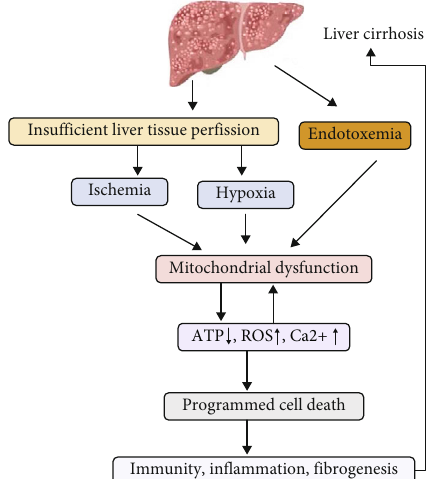
Figure 4: Mitochondrial dysfunction and liver cirrhosis. In liver cirrhosis, stimuli such as ischaemia, hypoxia, and endotoxaemia contribute to mitochondrial dysfunction. First, exposure of liver cells to a high level of endotoxin from the gastrointestinal tract inhibits enzyme dehydrogenase activity and blocks energy generation, and ROS production increases due to this interference of respiratory chain electron transfer. Second, unbalanced ROS levels lead to altered mitochondrial membrane permeability, induction of in fl ammatory signaling, and promoted activation of programmed cell death pathways. Additionally, ischaemia and hypoxia in the cirrhotic liver can cause cell membrane destruction, and Ca 2+ -ATPase activity at the cell membrane is inhibited. Ca 2+ intake is often accompanied by depolarization of the mitochondrial membrane and H + excretion. When the Ca 2+ concentration in the mitochondria is excessive, inner membrane pores are opened. As a result, mitochondrial membrane permeability is increased. Mitochondria become dysfunctional, which induces programmed cell death, death-related in fl ammation, the immune response, fi brosis, and regeneration and further aggravates cirrhosis, thereby forming a vicious